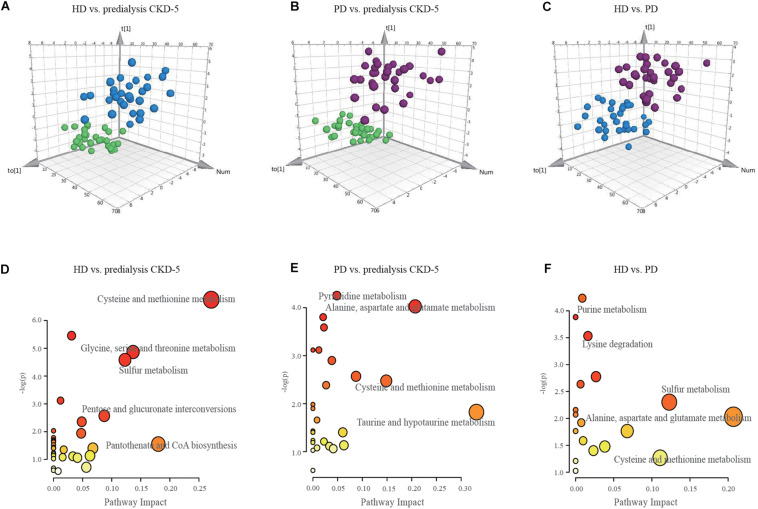
OPLS-DA score plots and disturbed metabolic pathways. The orthogonal projection to latent structure-discriminant analysis (OPLS-DA) score plots compared (A) HD to predialysis CKD-5, (B) PD to predialysis CKD-5, and (C) HD to PD. The disturbed metabolic pathways showed various metabolism changes when comparing (D) HD to predialysis CKD-5, (E) PD to predialysis CKD-5, and (F) HD to PD.